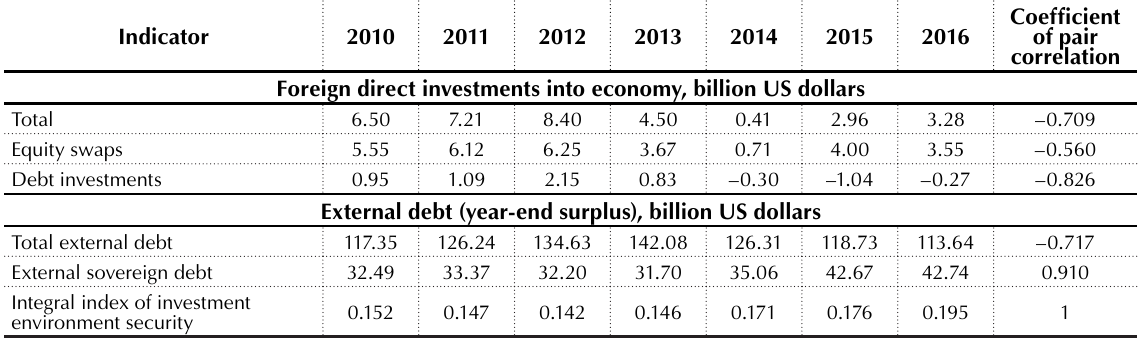
Table 3. Correlation between the integral index of investment environment security and indicators of foreign direct investment into the economy and external debt of Ukraine for 2010–2016 Source: Calculated by the authors on the basis of the data of the National Bank of